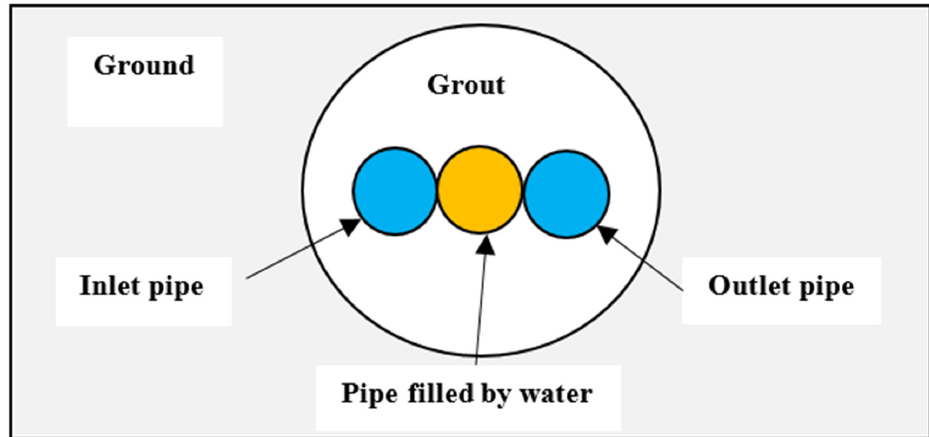
Figure 7. Cross section of new 3 pipe-type.